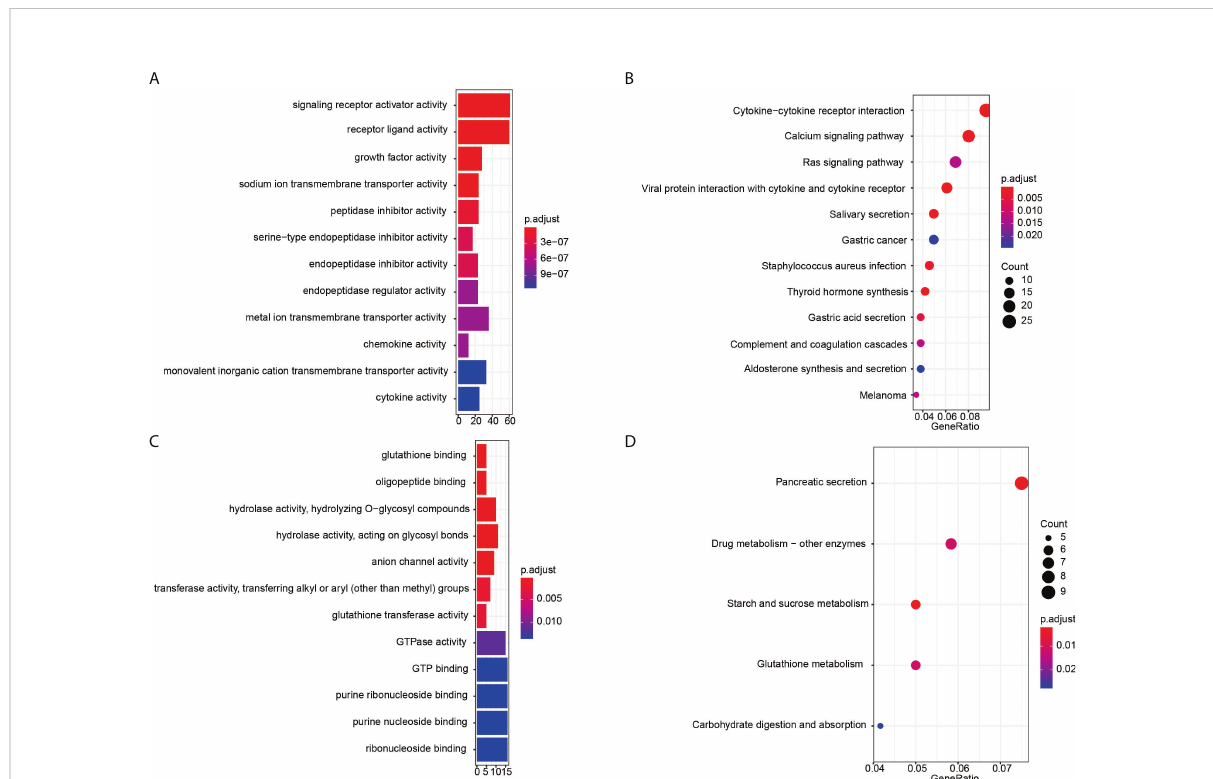
FIGURE 3 Enrichment analysis results. GO enrichment analysis results of signi fi cantly differentially expressed mRNAs (A) and CNVs (C) . The x-axis is gene counts, the y-axis is GO terms of molecular function. KEGG pathways of the differentially expressed mRNAs (B) and CNVs (D) . The x-axis is the ratio of genes in the corresponding pathway, and the y-axis is the name of the pathway.